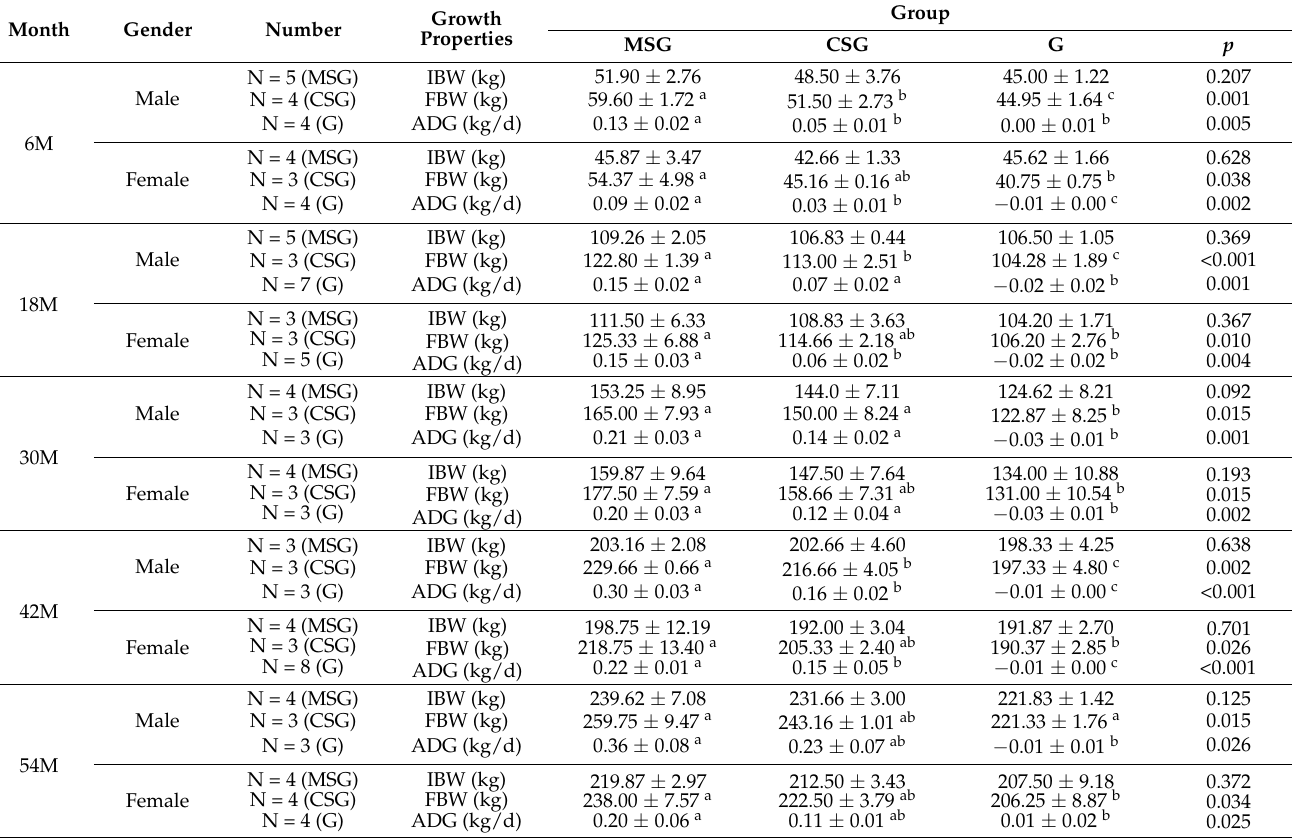
Table 2. Body weight and average daily gain of Tianzhu white yaks supplemented with various